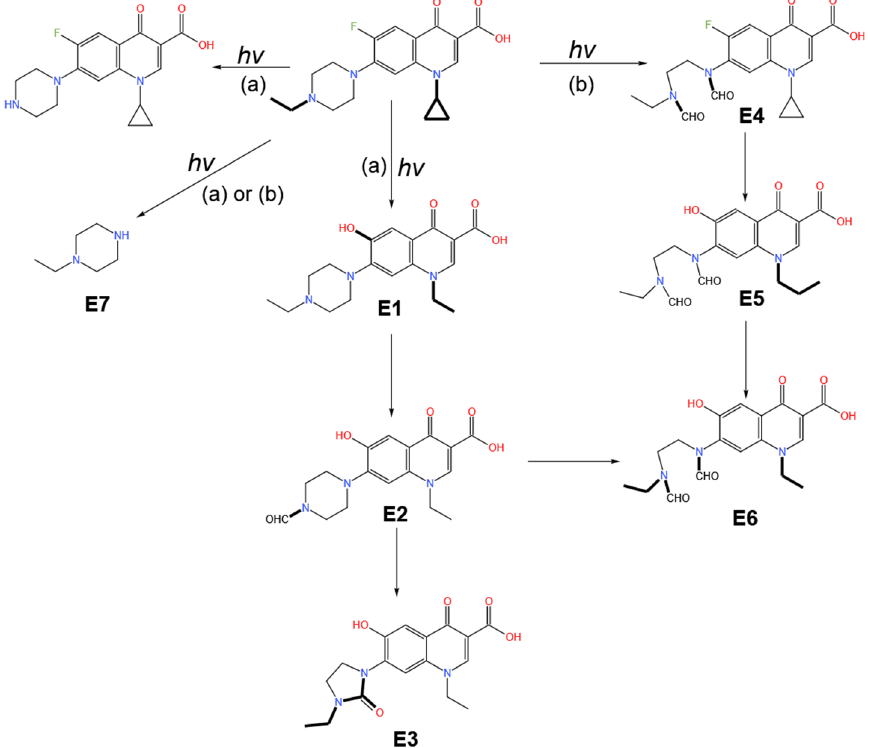
Figure 3. Photolysis pathways of enrofloxacin at pH4 ( a ) and pH8 ( b ). Reproduced with permission from Babic et al., Chemosphere [68]; published by Elsevier, 2013.